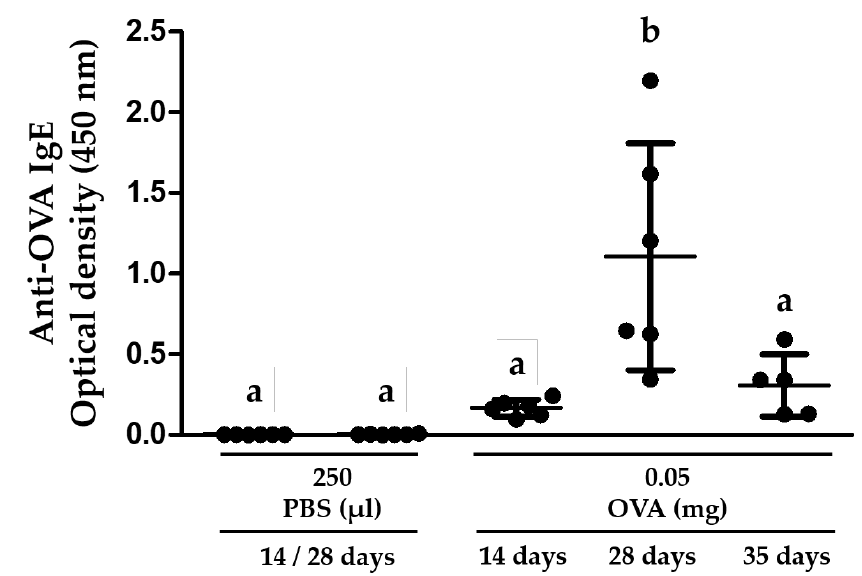
Figure 3. The frequency of ip injections influences the levels of anti-OVA IgE antibodies produced in BALB/c Mice. The animals (n = 5–6 per group) were randomly assigned to a 14-, 28- or 35-day protocol and were injected ip with 250 μL of 0.02% OVA (0.05 mg) for 2, 5, or 3 times respectively (see Figure 1 for details). The mice were exsanguinated after 14, 28 or 35 days according to the protocol used. Different letters mean statistical differences ( p < 0.05) by one-way ANOVA and Tukey’s multiple comparison tests. All serum samples were evaluated using ELISA.